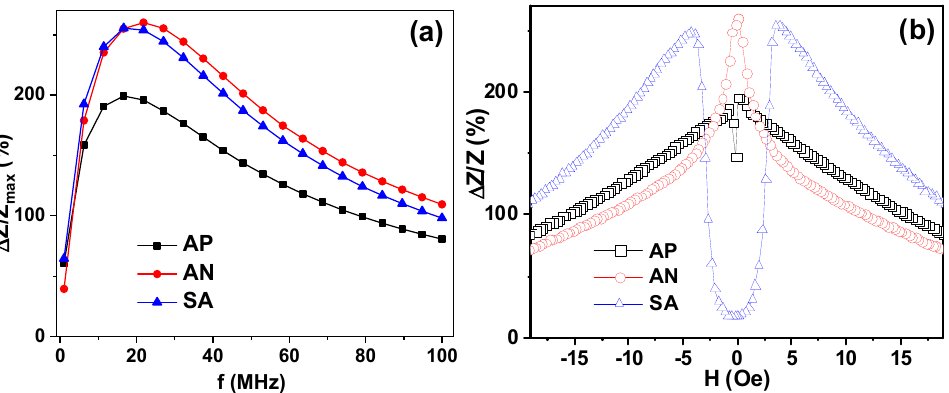
Figure 6. ( a ) Frequency dependence of the maximum MI ratio for amorphous Fe 3 Co 67 Cr 3 Si 15 B 12 ribbons in AP, AN and SA states, measured in longitudinal MI configuration. ( b ) The applied field dependence of the MI ratio for the same samples with length l = 45 mm and f = 22 MHz.